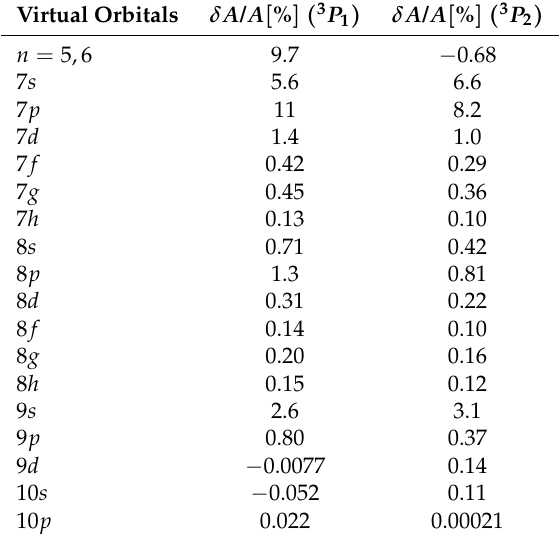
Table 3. Relative change in the hyperfine structure constant A from the preceding calculation as the virtual orbitals were included in the order n = 5,6, 7 s . . . 7 h etc. with single, vv and cv substitutions. Virtual Orbitals δ A / A [ % ] ( 3 P 1